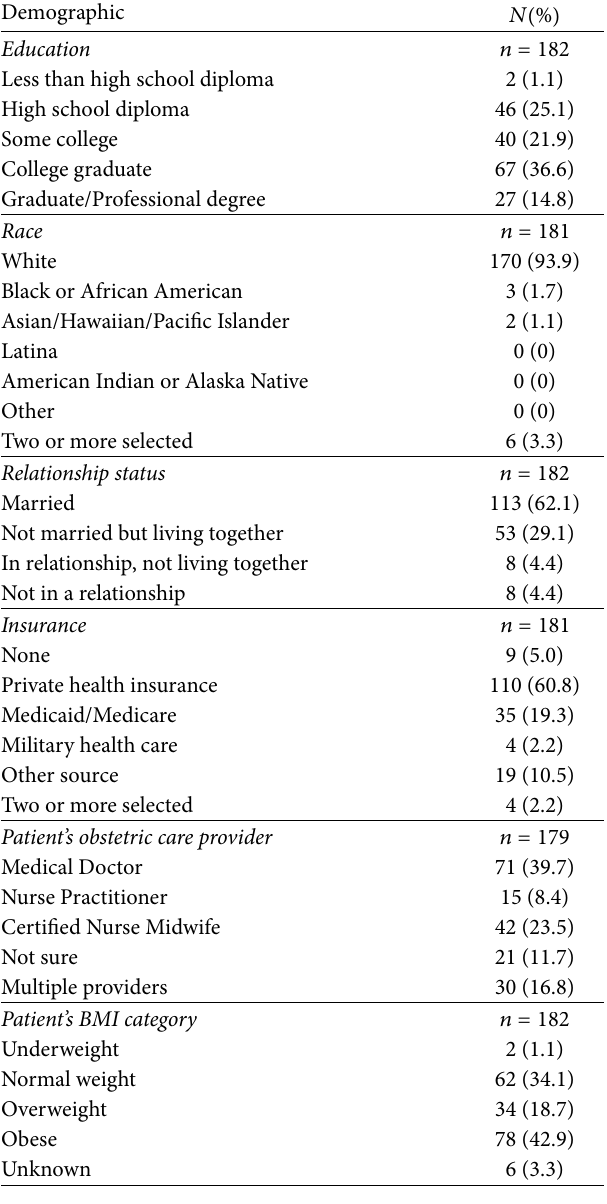
Table 1: Demographic information for the 182 women that completed the